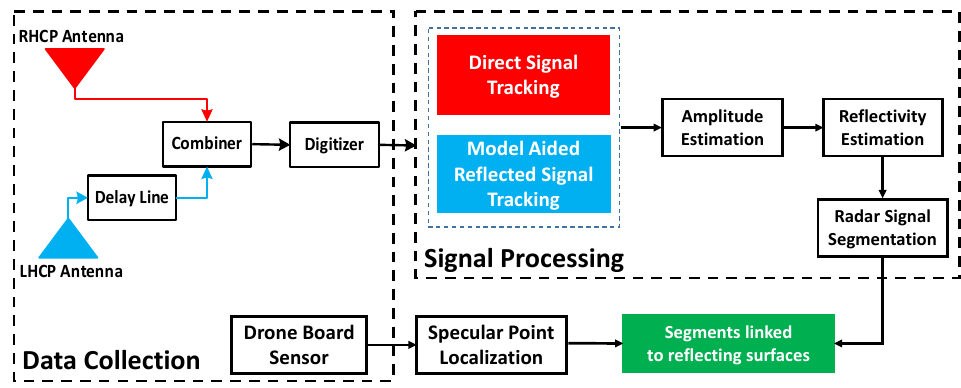
Figure 2. Airborne GNSS-R